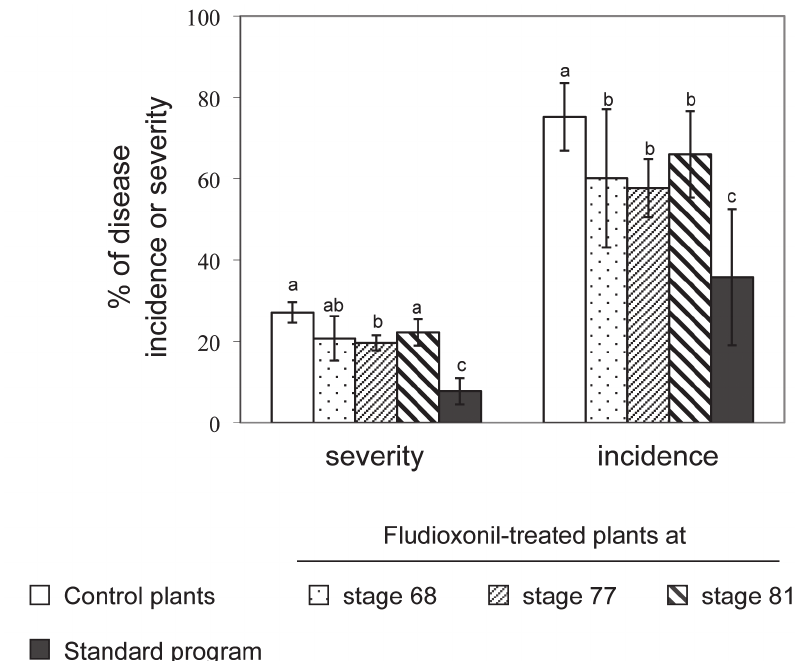
Figure 1. Mean severity (a) and incidence (b) of grey mould on grape berries at harvest, following different fungicide treatments. The effectiveness of fludioxonil is compared according to stage of application: end of flowering (BBCH stage 68), bunch closure (BBCH stage 77), or veraison (BBCH stage 81). Means with the same letter were not signifi- cantly different ( P <0.05) as determined by the Student’s t